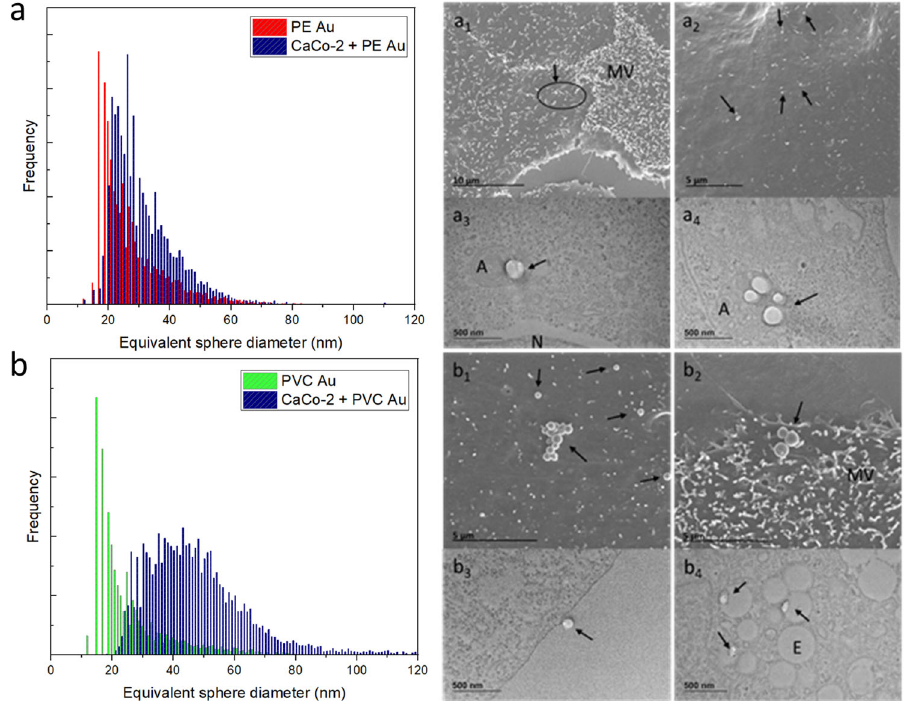
Figure 6. ( a ) Equivalent sphere diameter distribution of PE Au (red) and CaCo-2 cells, incubated with PE Au for 48 h (black) at a concentration of 100 µ g mL − 1 . ( a 1 , a 2 ) SEM images of CaCo-2 cells incubated with PE Au for 48 h reveals the presence of nanoplastics both interacting with the cell membrane and microvilli (MV) (arrows). ( a 3 , a 4 ) The TEM images of slices of CaCo-2 cells after 48 h incubation with PE Au, displaying the presence of PE Au (arrows), confirming the internalization in the amphisomes (A); nucleus (N). ( b ) Equivalent sphere diameter distribution of PVC Au and CaCo-2 cells, incubated with PVC Au for 48 h at a concentration of 100 μ g mL − 1 . Both SEM ( b 1 , b 2 ) and TEM ( b 3 , b 4 ) analyses of the sample display the presence of nanoplastics (arrows), both internalized and interacting with the cell membrane. Particles are visible inside the endosome (E) also confirming the presence of Au NPs via TEM.